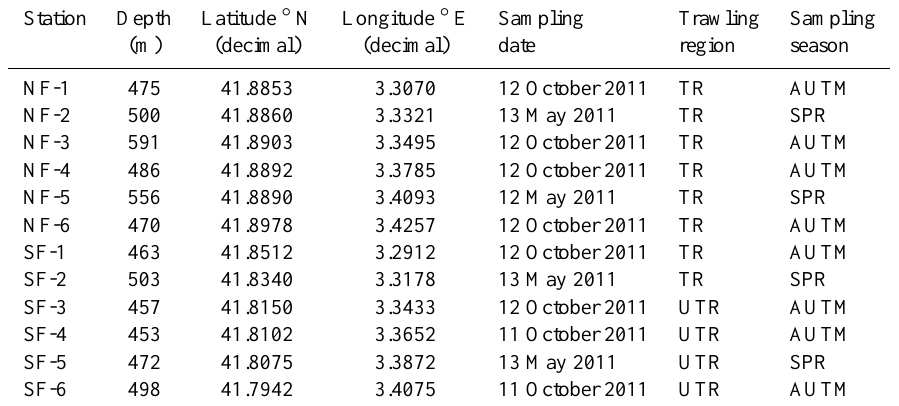
Table 1. Names, depths, coordinates and sampling dates of the coring stations. Trawled (TR) and untrawled (UTR) regions as well as spring (SPR) and autumn (AUTM) sampling seasons corresponding to each station are also indicated.